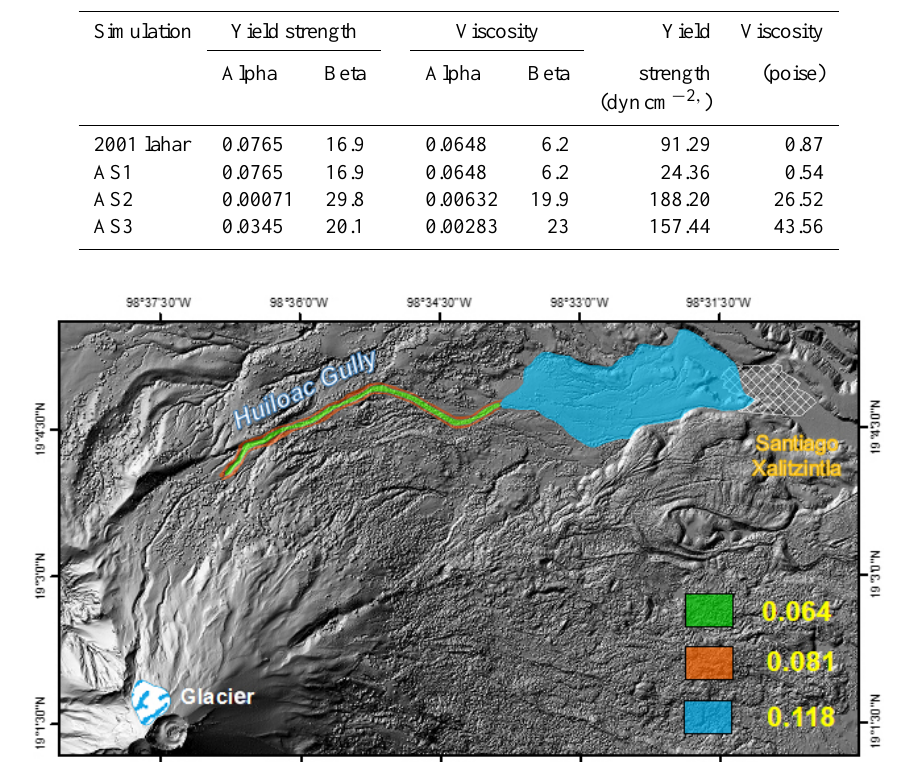
Table 1. Values of rheological coefficients used for the different flow scenarios. Yield strength and viscosity were obtained by the empirical formulas used by FLO2D and from O’Brien and Julien (1988).